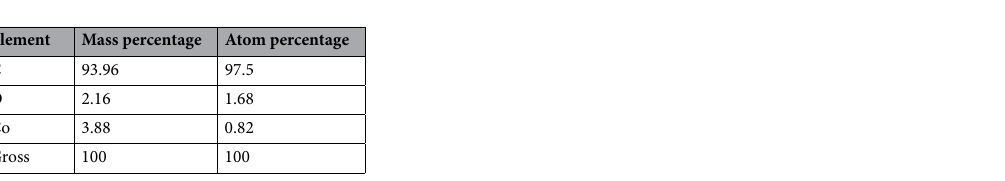
Table 1. X-ray energy spectrum analysis result of Co/PCNF